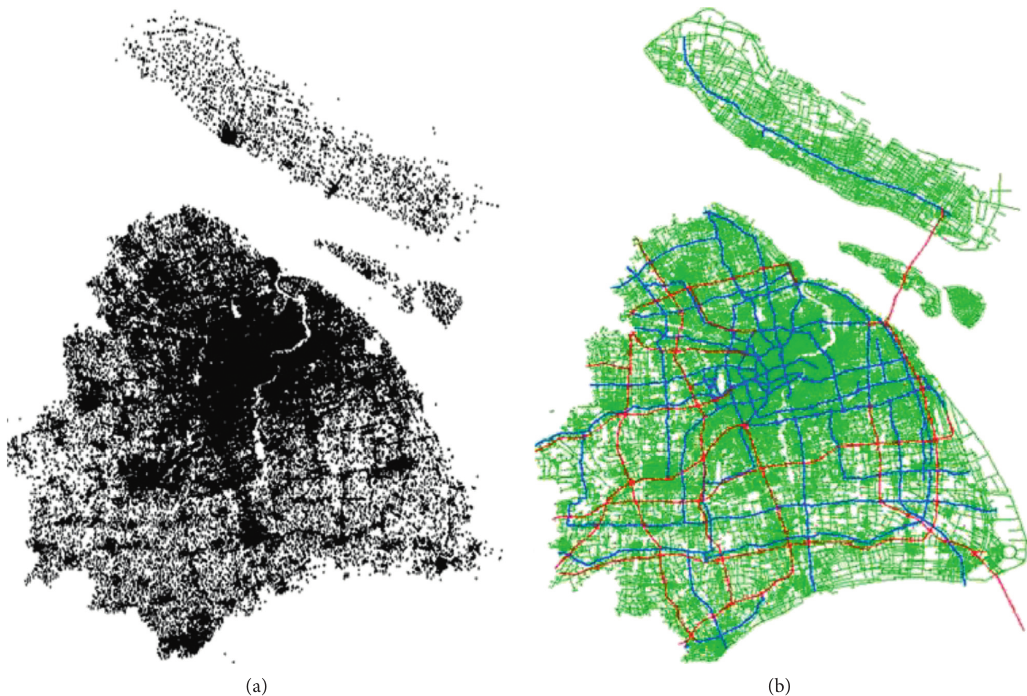
Figure 1: POI distribution (a) and hierarchical road distribution (b) (red: freeway; blue: major road; green: local road).